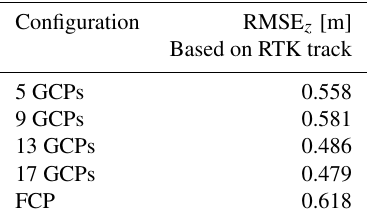
Table 2. RMSE of different GCP combinations and